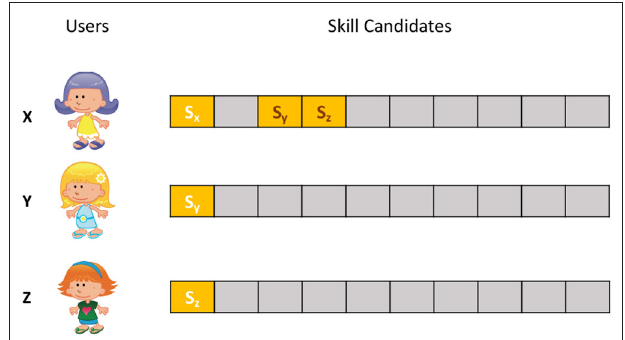
FIGURE 4 | Illustration of collaborative data relabeling (CDR). In skill recommendation, only the top-1 skill is presented to users. Given a user x who invoked voice assistant with some utterance, to know her responses to skills s y and s z that were not presented to her, we found two users y and z who spoke similar utterances and were suggested with skills s y and s z , respectively, and use their responses to relabel user x’s feedback to skills s y and s z